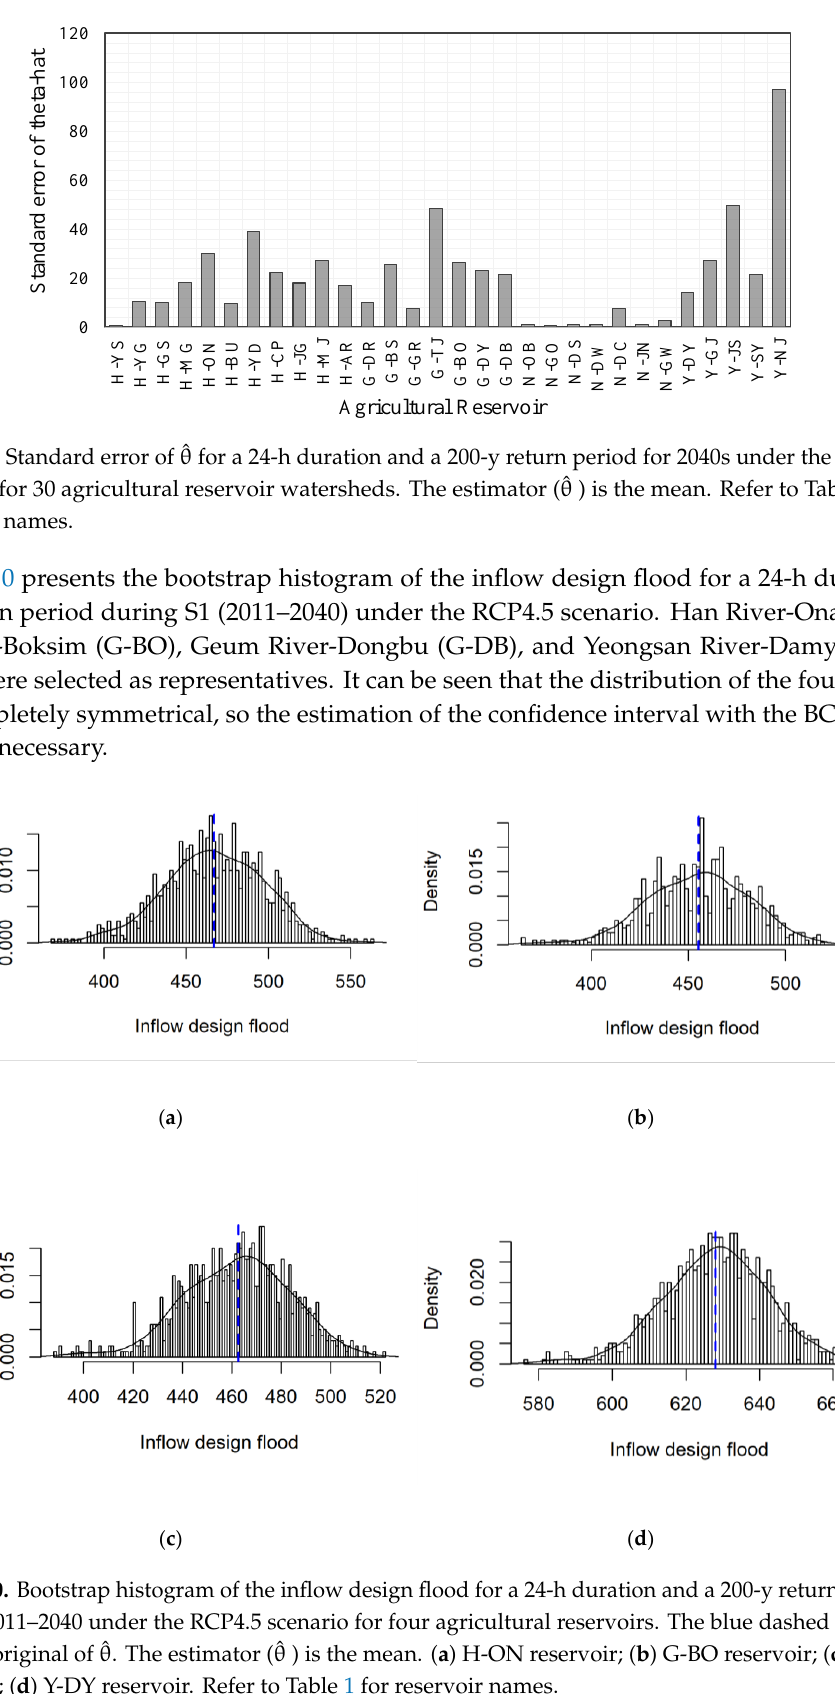
Figure 8. Bias of θ̂ for a 24-h duration and a 200-y return period for 2040s under the RCP4.5 scenario for 30 agricultural reservoir watersheds. The estimator ( θ̂ ) is the mean. Refer to Table 1 for reservoir names.